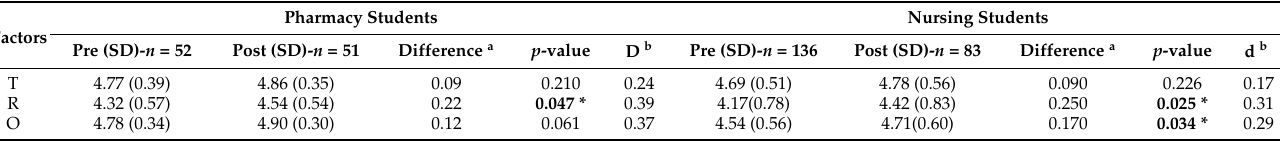
Table 4. Comparison of pre- to post-test factor